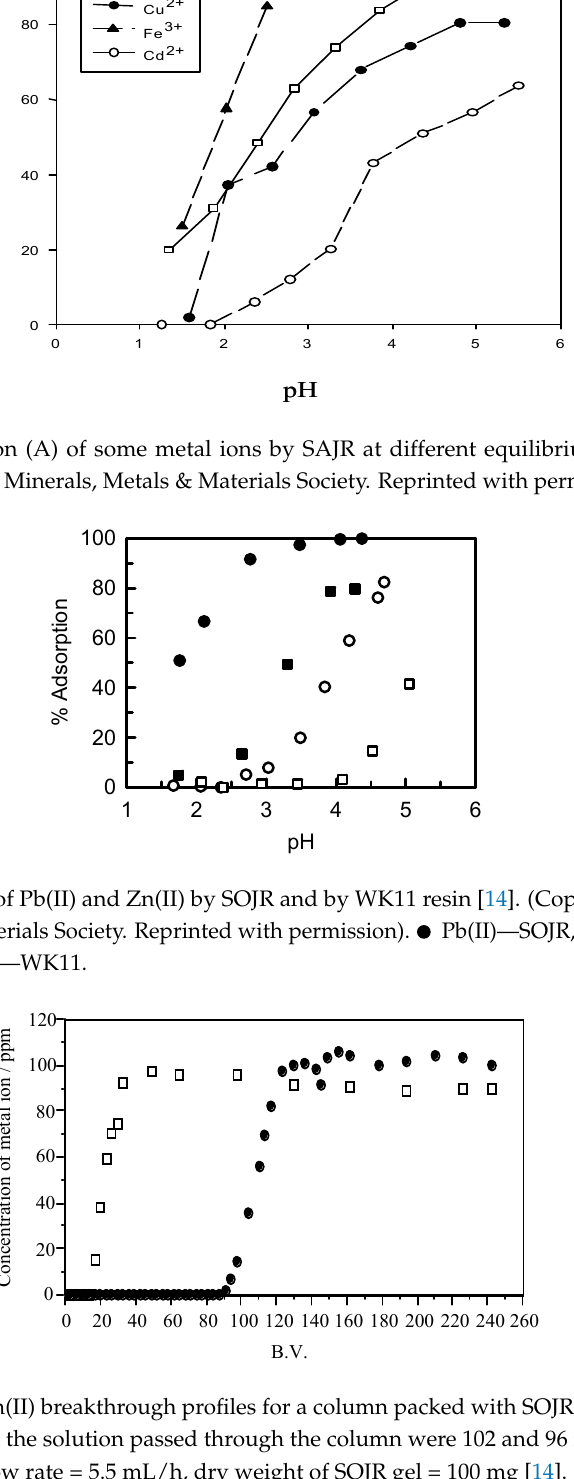
Figure 13. % adsorption (A) of some metal ions by SOJR at different equilibrium pH values [14]. (Copyright 2003 by The Minerals, Metals & Materials Society. Reprinted with permission).